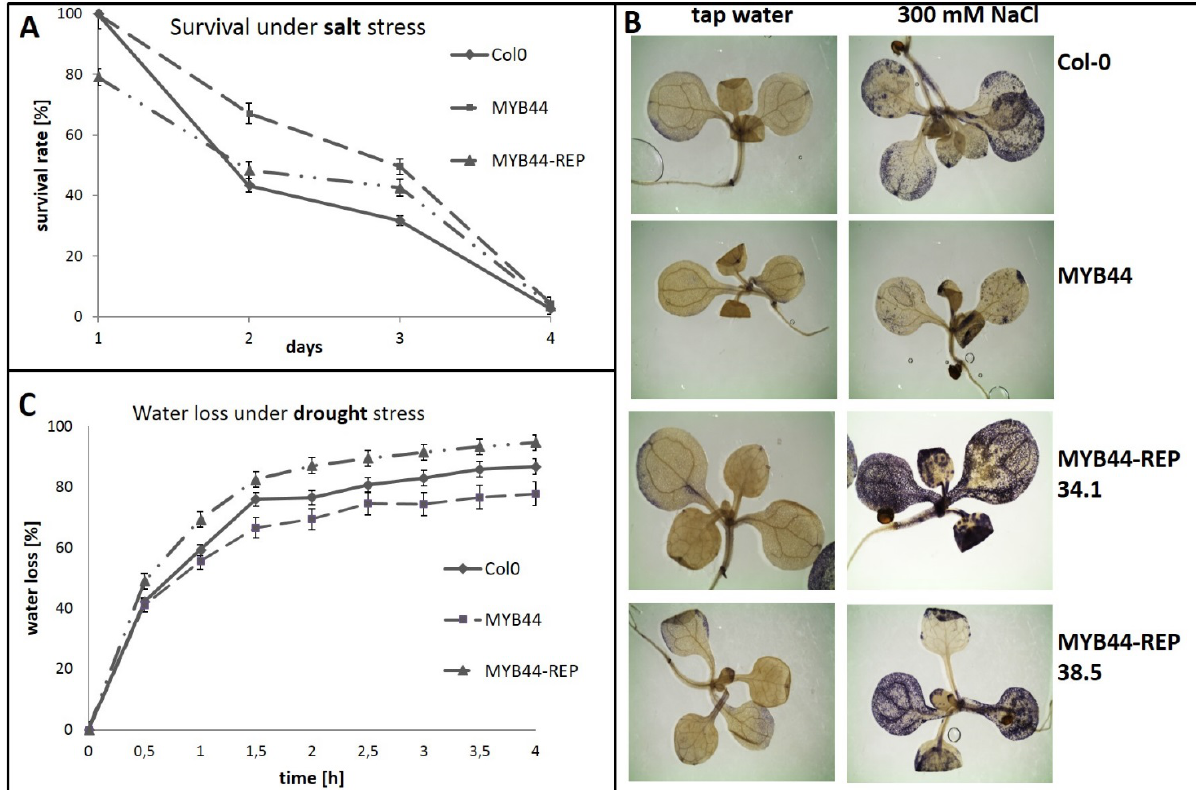
Figure 4. MYB44-REP overexpression compromises abiotic stress tolerance. ( A ) Survival under high-salinity conditions. Three-day-old seedlings grown under standard conditions were transferred onto growth medium supplemented with 150 mM NaCl. Seedling survival was monitored over a 4-day period. About 50 seedlings of 4–6 independent lines each were tested. Results of two independent experiments are shown; ( B ) Superoxide accumulation upon osmotic shock treatment. Twelve-day-old seedlings were incubated in tap water with or without 300 mM NaCl for 6 h. Superoxide radicals were visualized by nitro blue tetrazolium (NBT) staining. Five seedlings per treatment per line were tested in parallel; one representative image is shown. The experiment was repeated twice; and ( C ) Drought stress. Roots were detached from 3-week-old seedlings that had grown on standard medium. Water loss was determined at regular intervals over a 4 h period. The experiment was repeated